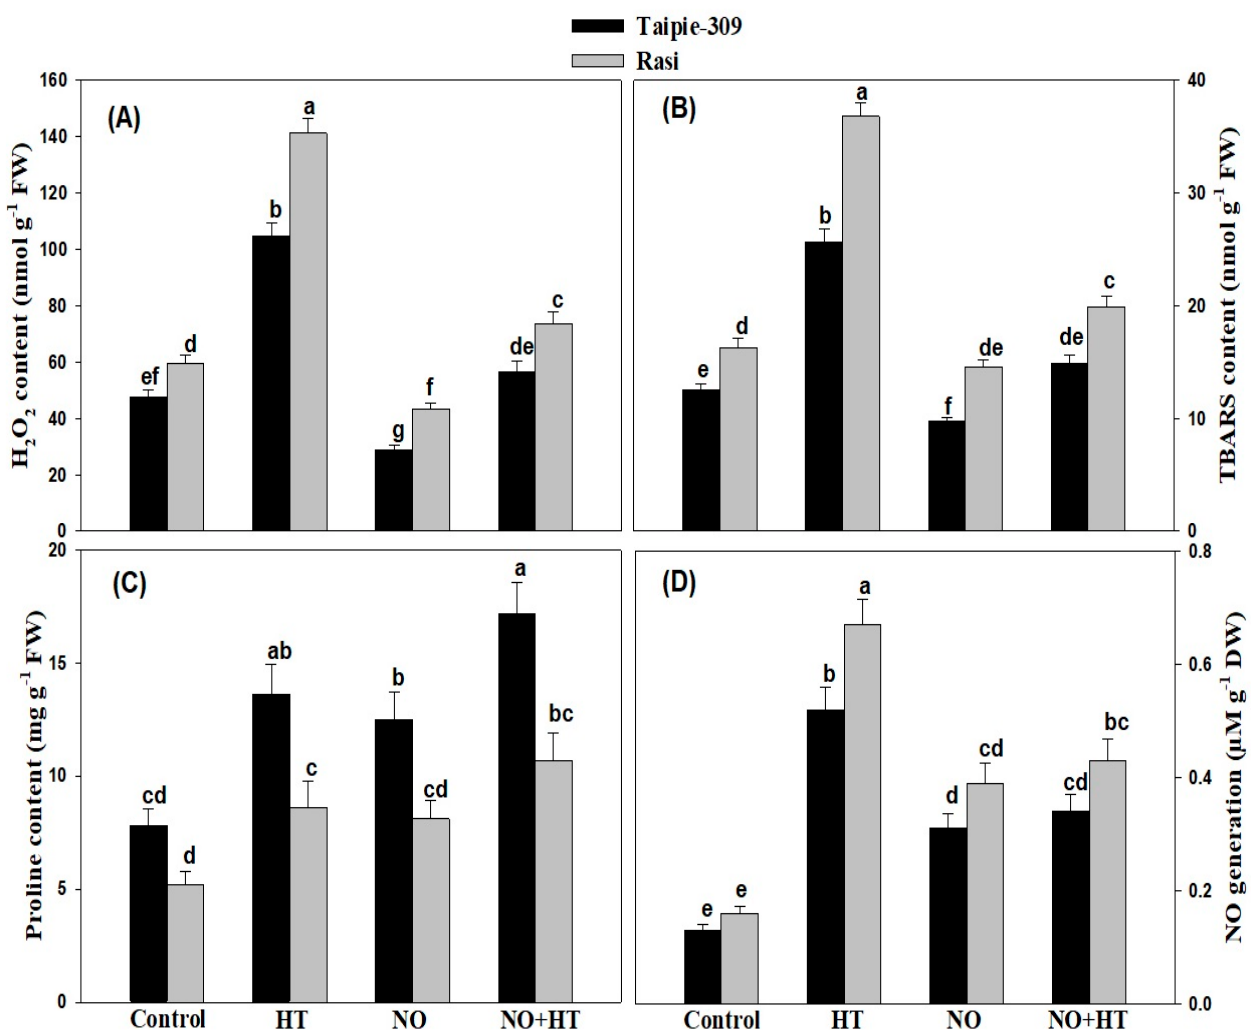
Figure 1. Leaf H 2 O 2 content ( A ), TBARS content ( B ), Proline content ( C ), and NO generation ( D ) in Taipie-309 and Rasi cultivars of rice ( Oryza sativa L.) at 30 days after germination (DAG), plants were grown with/without high temperature stress and treated with foliar 100 µ M SNP (NO donor). Data are presented as treatments mean ± SE (n = 4). The values followed by same letters above bars represent that data did not differ significantly by LSD test at p < 0.05. FW, fresh weight; DW, dry weight.